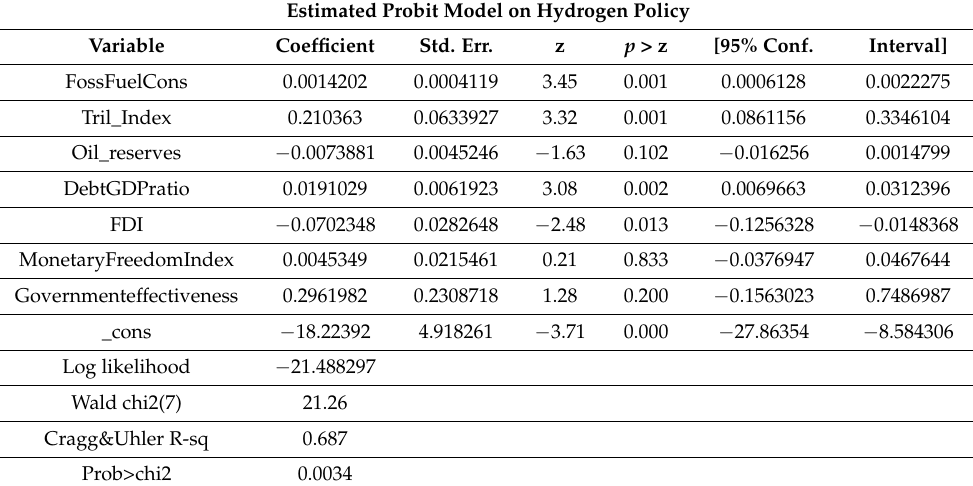
Table 4. Binary probit model 1